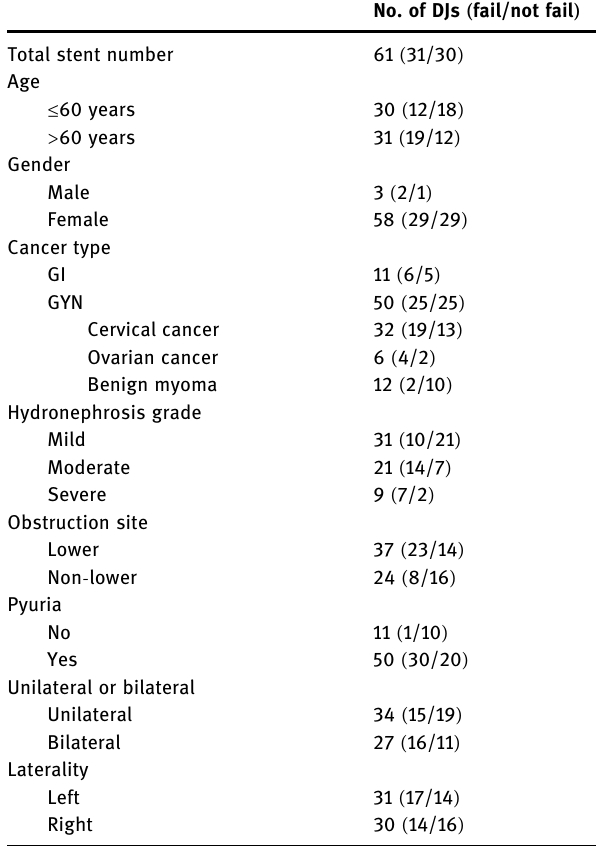
No. of DJs ( fail/not fail